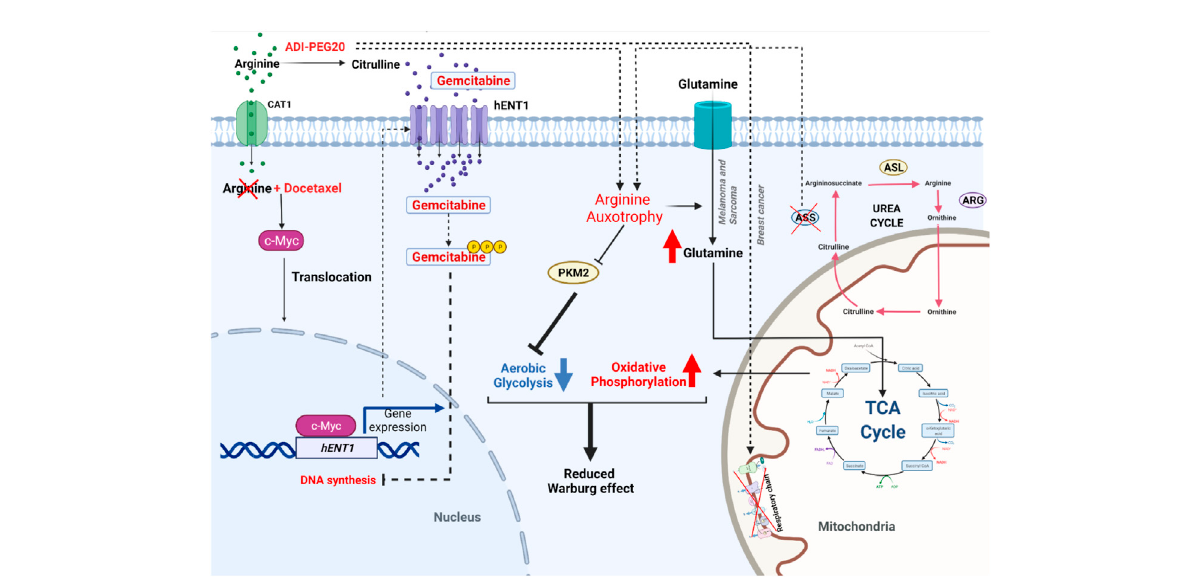
FIGURE 7 Mechanisms of action of ADI-PEG20 combined with Docetaxel and Gemcitabine in Ongoing Clinical for ASS1 -de fi cient cancer (adapted from Prudner et al., 2019). Shown on the left are the synergic molecular mechanism of ADI-PEG20, Docetaxel, and Gemcitabine in ASS1 -de fi cient OS. Together with Docetaxel, the arginine starvation induced by ADI-PEG20 induces c-Myc translocation. c-Myc acts as a transcription factor that stimulates the expression of the hENT1 gene which is important for Gemcitabine uptake to inhibit DNA synthesis in OS. Shown on the right are the metabolic impacts in arginine auxotrophic conditions, where the loss of arginine inhibits the activity of glycolysis-mediated enzyme PKM2, resulting in decrease of aerobic glycolysis. Moreover, in ASS1 -de fi cient breast cancer, ADI-PEG20 treatment inhibits the mitochondrial activities, resulting in the inhibition of mitochondrial respiratory complexes. While in melanoma and sarcoma, arginine starvation causes the increase of extracellular glutamine uptake with higher expression of glutaminolysis-related actors, resulting in the metabolic reprogramming for the consumption of glutamine as a fuel source via TCA cycle, and OXPHOS. This metabolic pro fi le represents the reduced Warburg